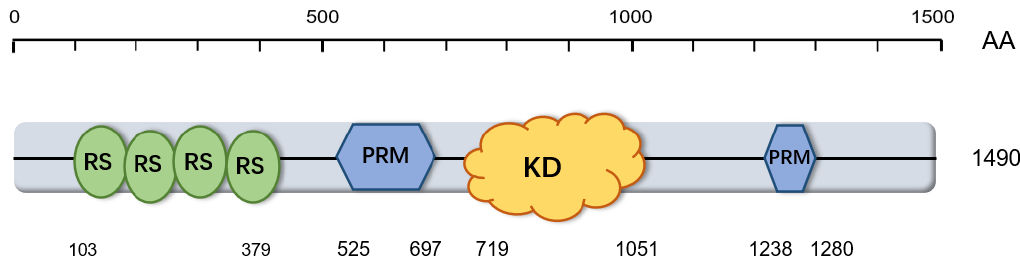
Figure 2. Schematic diagram of CDK12 protein structure. AA: amino acid; RS: arginine/serine-rich domain; PRM: proline-rich motif; KD: kinase domain.